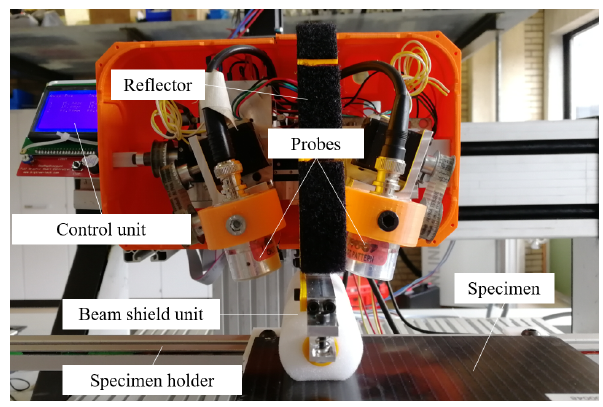
Figure 3. Open ultrasound sensor including beam shield and two slanted ACU probes.